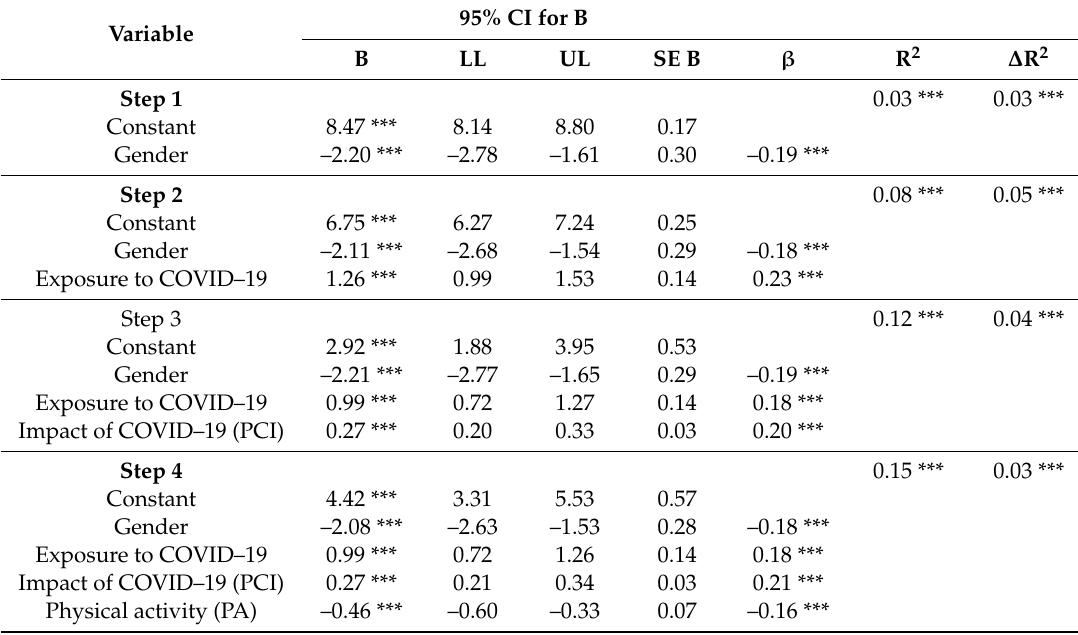
Table 7. Hierarchical regression results for